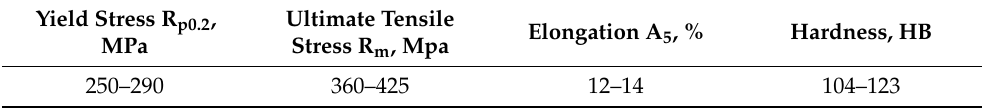
Table 1. Chemical composition of the EN AW-2024-T3 aluminium alloy (wt.%).